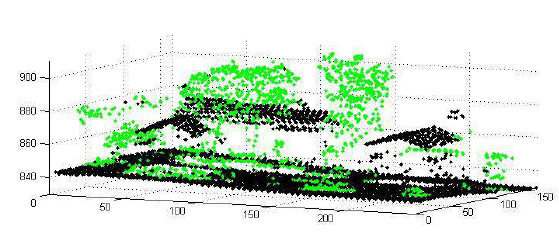
Figure 4. Points color labeled as “scatter” (green) or “surface” (black) points.